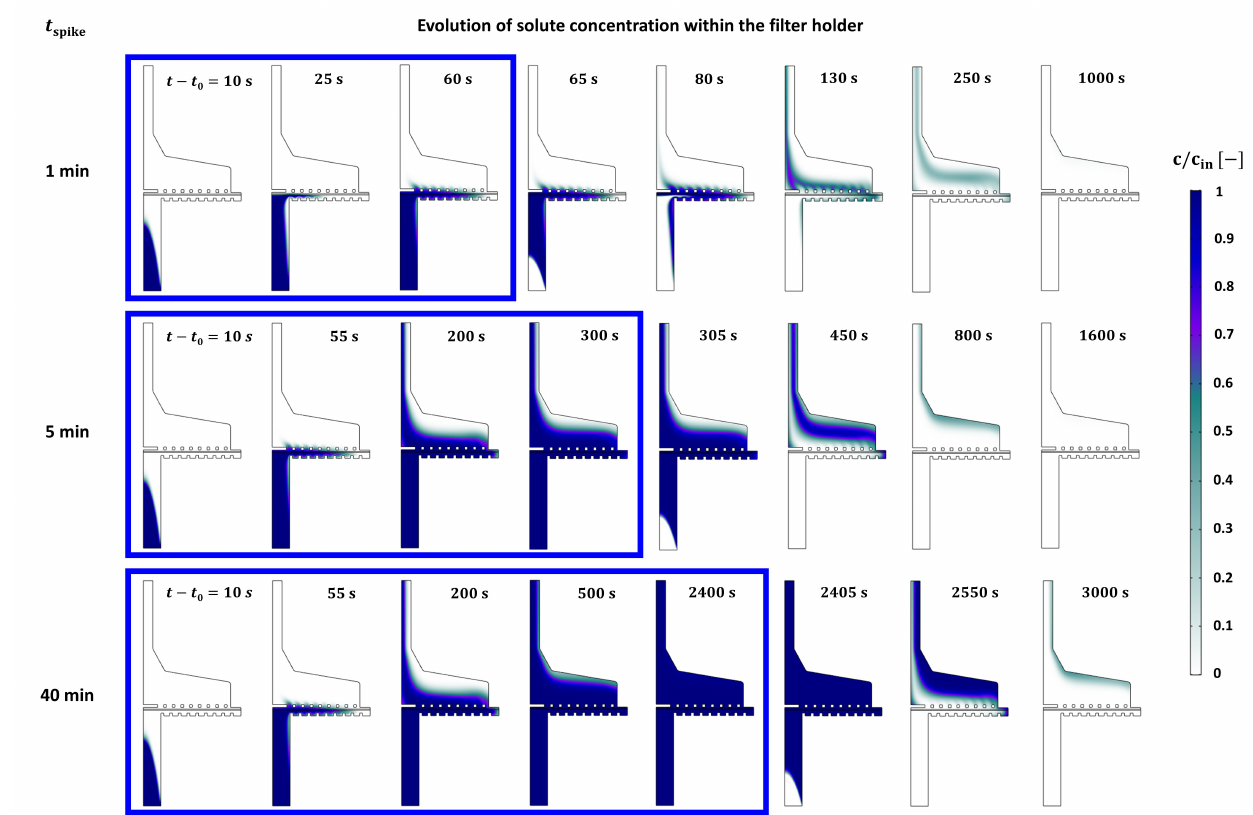
Figure 9. Evolution of solute concentration within the filter holder at varying spiking duration. Blue boxes represent the time duration before the end of each spike.